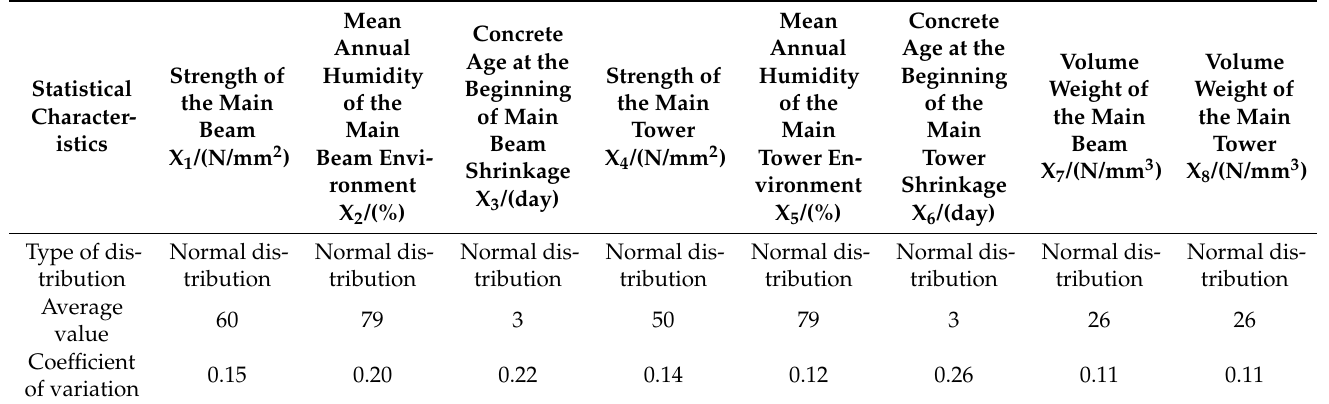
Table 1. Statistical characteristics of random parameters.